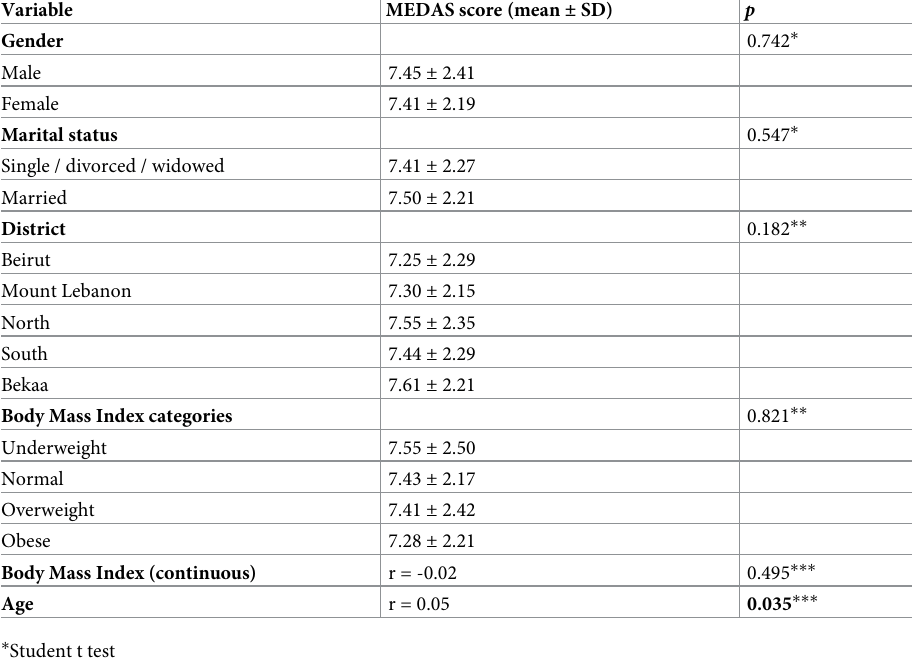
Kuwaiti sample [29]. Furthermore, Radwan et al. also reported that 31.8% of Emiratis increased food consumption [30]. Cheikh et al also reported that close to 40% of the Lebanese participants in their study were not consuming fruits and vegetables on a daily basis [31], while Dimassi et al reported a significant increase in consumption of fruits and vegetables [32]. Nevertheless, as a result of the pandemic, almost 40% of the participants have reported weight gain almost [33]. Unhealthy dietary patterns and weight gain are especially problematic during a pandemic since healthy dietary habits are the cornerstone to enhanced immunity, which could help ward of the severe consequences of viruses [34]. Table 5. Bivariate analysis of factors associated with the MEDAS